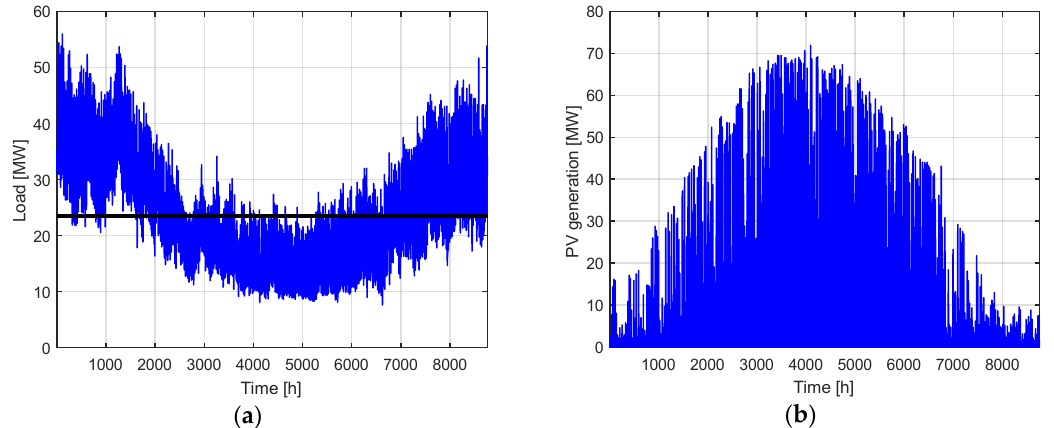
Figure 3. The input data to the load flow simulation: ( a ) Load data; ( b ) photovoltaic (PV) generation.